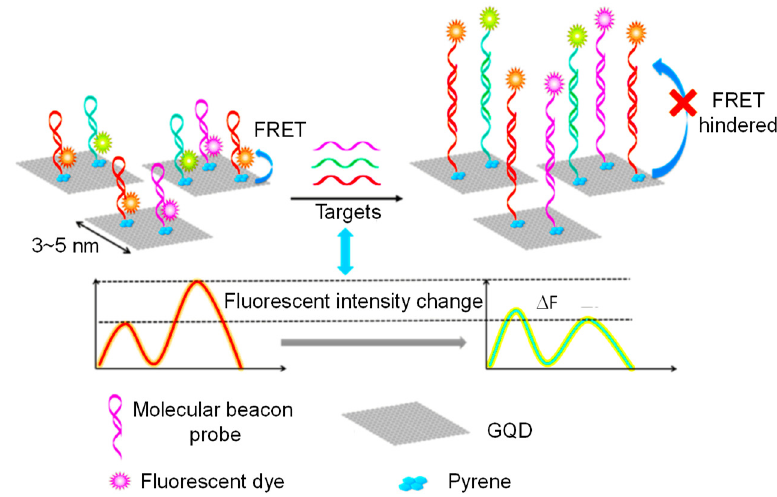
Figure 14. Biosensing system based on FRET change between GQDs and pyrene-modified molecular beacon probes (py-MBs) for determining miRNAs [236].